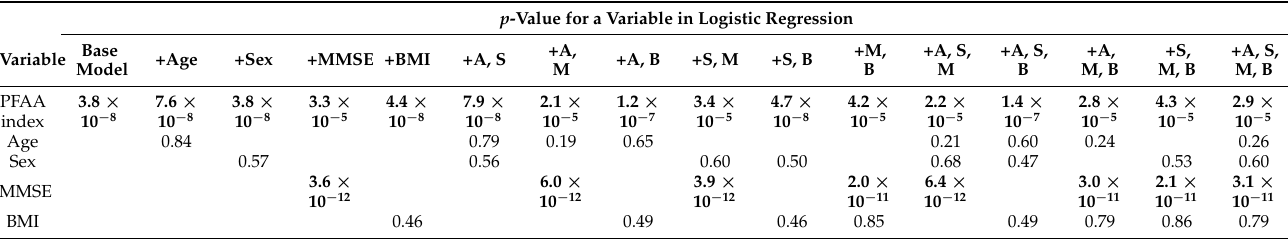
Table 3. Independence between the PFAA index and potential